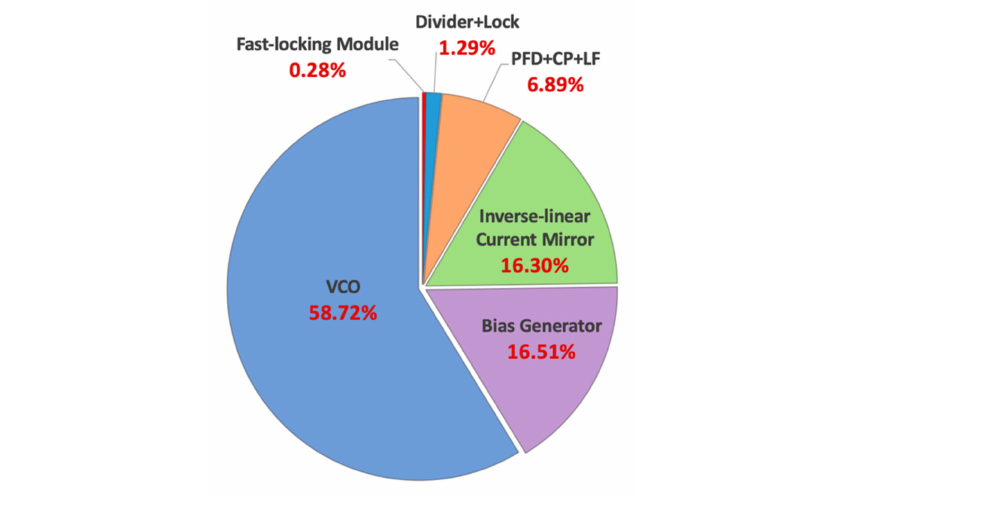
Figure 8. Power consumption of the proposed AFL-SPLL.